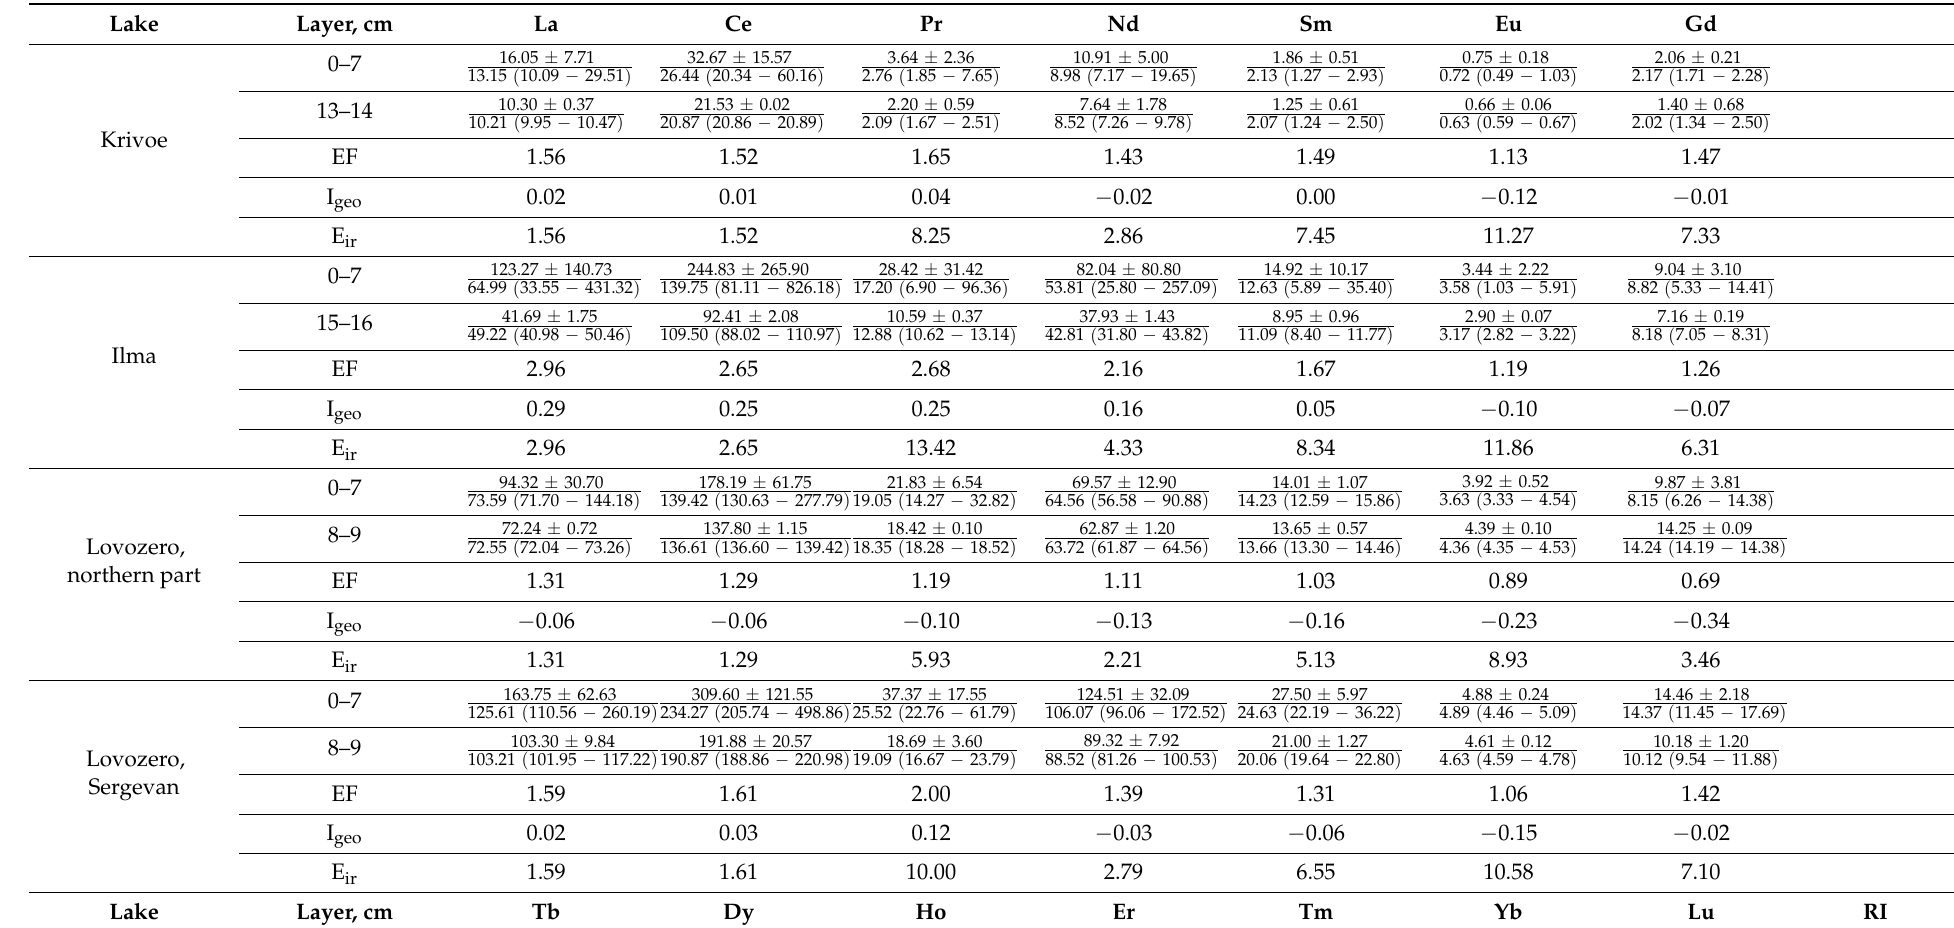
Table 5. Concentrations of REEs in the surface and background layers of BS (mg/kg), enrichment factor, geoaccumulation index, potential ecological risk index factor and potential ecological hazard